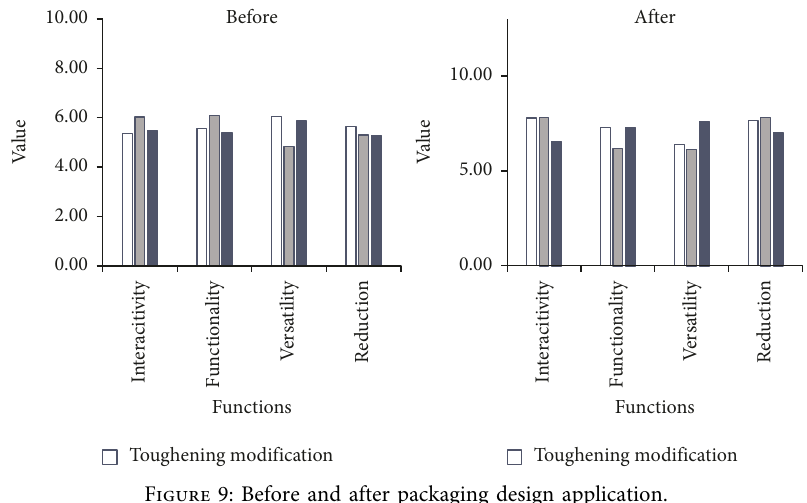
Figure 9: Before and after packaging design